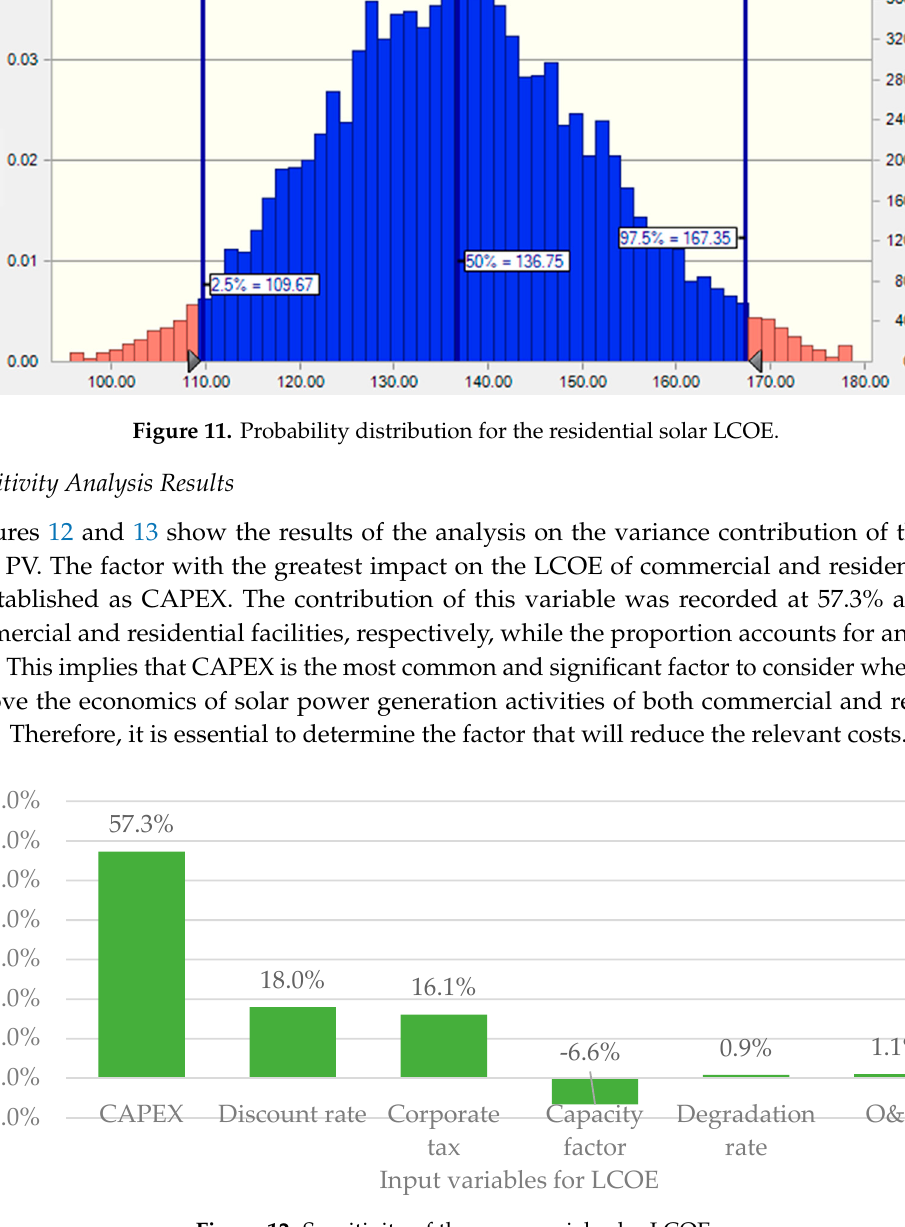
Figure 13. Sensitivity of the residential solar LCOE. 5. Discussion The stochastic LCOE analysis methodology proposed in this study was applied to solar PV for residential and commercial use in South Korea. The deterministic LCOE performed in most existing studies does not indicate the uncertainty of the input variable. Although the sensitivity analysis of the deterministic methodology shows the uncertainty of input variables, the number of scenarios is limited. This study is meaningful in that the confidence interval of the results is derived by reflecting the stochastic characteristics of the input variable instead of finding the deterministic LCOE. This study also contributed to producing realistic analysis results by collecting the actual data generated in the solar PV project. Among the input variables, the capacity factor was set to the optimal distribution function using the actual power generation data of solar PV. As a result of statistical analysis, significant statistical values, such as a reference value, an average, a median value, a standard deviation, a minimum value, and a maximum value, were derived. Commercial solar LCOE was estimated to range between KRW 115 (10 cents)/kWh and KRW 197.4 (18 cents)/kWh at a 95% confidence level. The median was valued